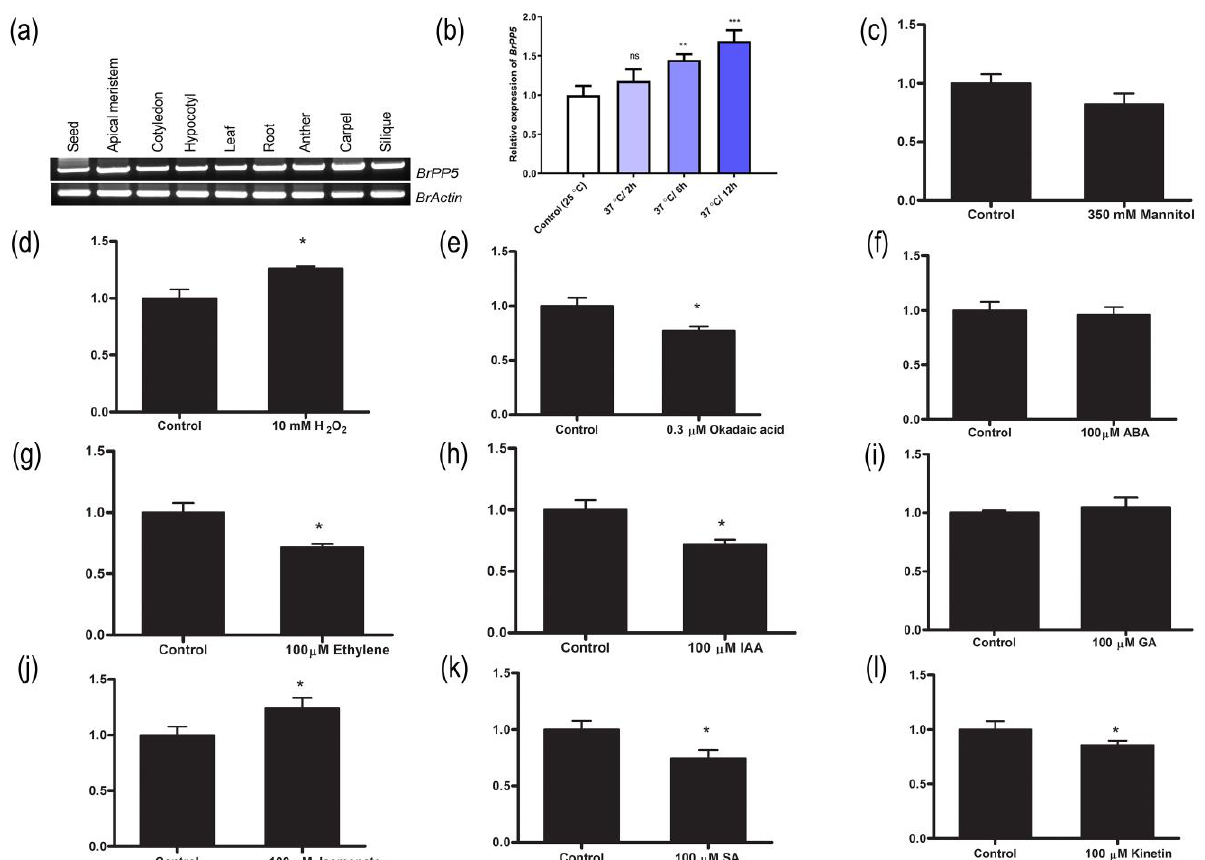
Figure 1. BrPP5.2 expression profiling across different tissues and treatment. ( a ) RT-PCR results showed the expression of BrPP5.2 in vegetative (apical meristems, cotyledon, hypocotyl, leaf, and root) and reproductive (seed, anther, carpel, and silique) tissues of B. rapa . ( b – l ) The quantitative RT-PCR results showing the relative expression pattern of BrPP5.2 in B. rapa exposed to a high temperature (37 °C) at different times ( b ), exogenously supplied 350 mM Mannitol ( c ), 10 mM hydrogen peroxide ( d ), AtPP5 inhibitor, okadaic acid (0.3 µ M) ( e ), and phytohormones (100 µ M each) such as abscisic acid ( f ) , ethephon ( g ), indole acetic acid ( h ), gibberellins ( i ), methyl jasmonate ( j ), salicylic acid ( k ) and kinetin ( l ). Each column represents the normalized gene expression values derived from qRT-PCR replicates, while error bars denote the standard deviations. One-way ANOVA (Dunnett’s multiple comparisons) test was performed in GraphPad Prism 8.0.2 to determine the significant variation from controls grown under optimal growth conditions. Ns = non-significant; * = p <